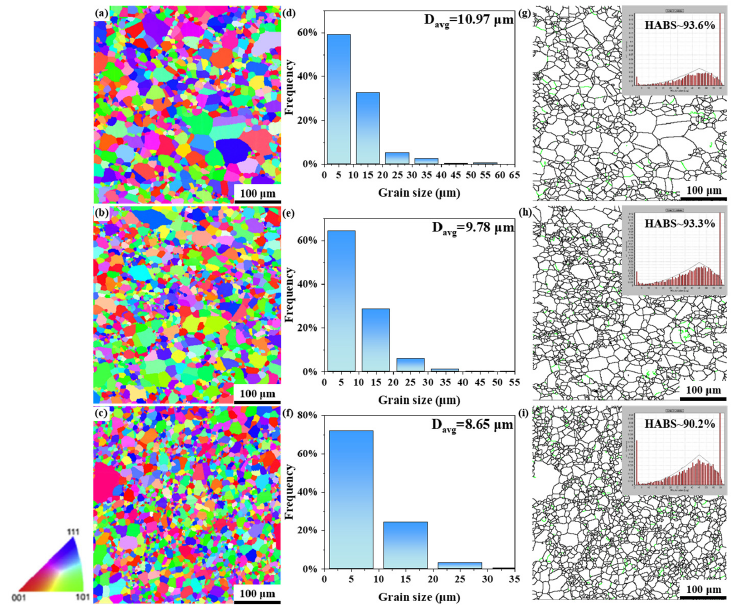
Figure 13. Inverse pole figure and Frequency histogram of grain together with distribution of grain boundary misorientation in heat-treated Sc-doped RR1000: ( a , d , g ) 0 wt.% Sc, ( b , e , h ) 0.048 wt.% Sc, ( c , f , i ) 0.064 wt.% Sc. Green lines represent the low angle boundaries (LABs) (0–15°) but the high angle boundaries (HABs) (>15°) were indicated by black lines.